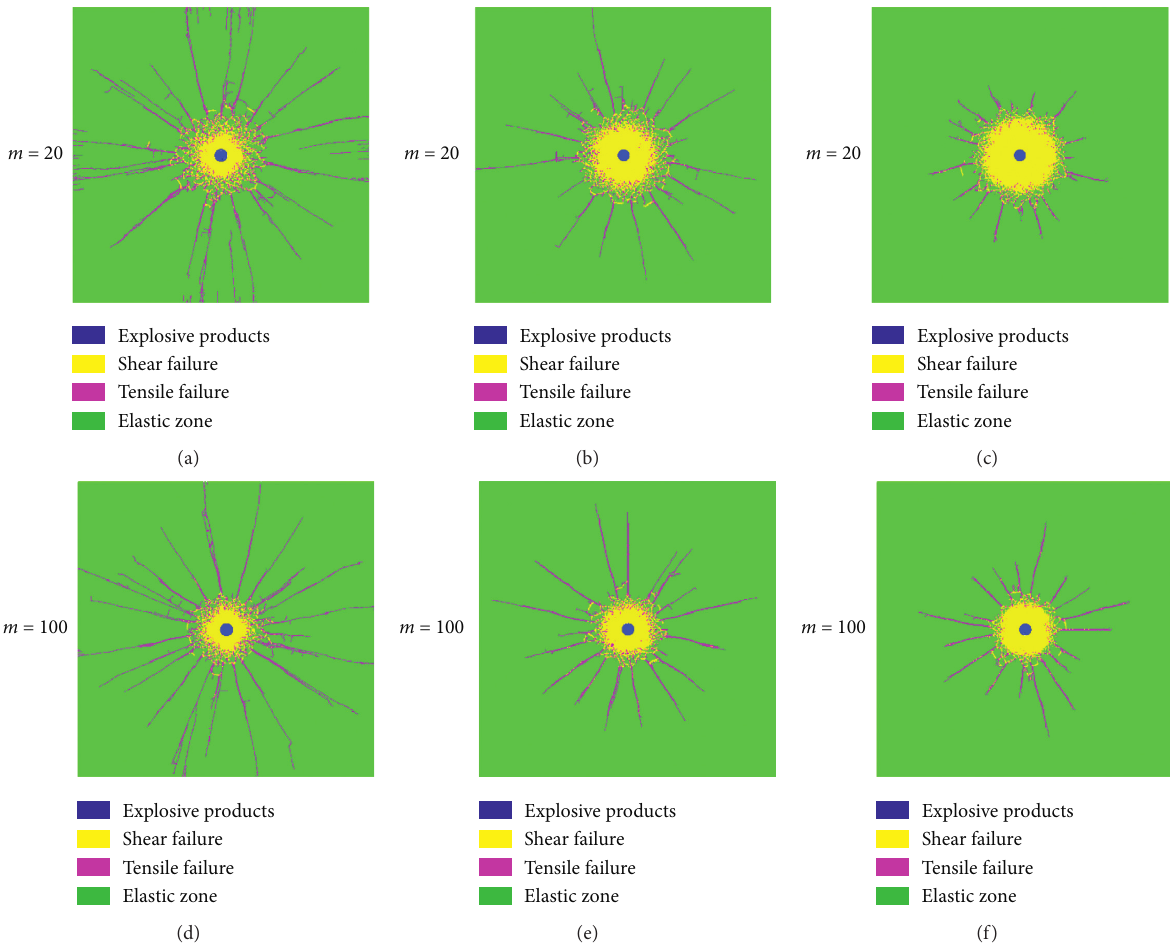
Figure 19: Comparison of blast-induced fractures under different P (b) P x � 20MPa, P y � 20 MPa. (c) P x � 30 MPa, P y � 30MPa. (d) P x � 10 MPa, P y � 10MPa. (e) P x � 20MPa, P y � 20 MPa. (f) P x � 30MPa, P y �